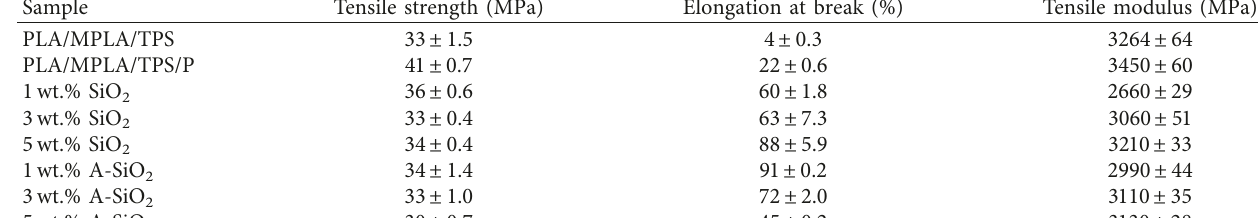
Table 5: Tensile properties of PLA/MPLA/TPS and various blends and composites.